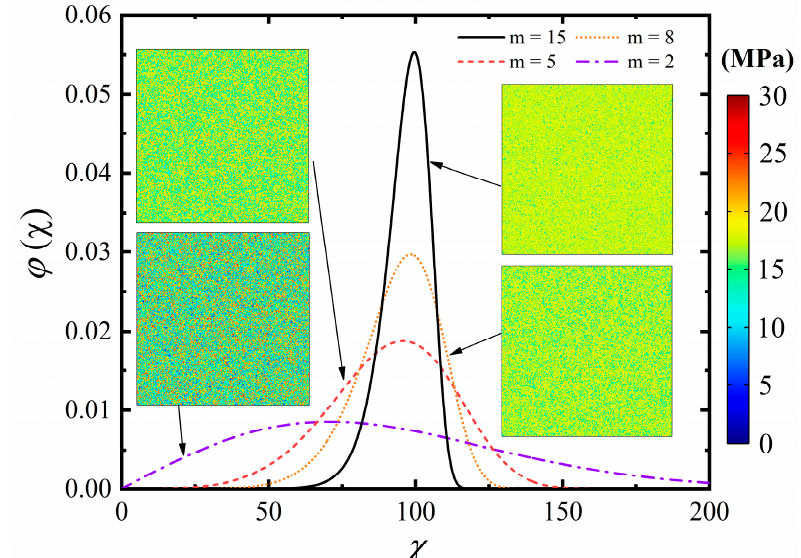
Figure 11. The number of elements with a particular value as a function of that value for different homogeneity indices (m = 2, 5, 8, and 15) at a given scale parameter of β = 100. Snapshots of the numerical specimens are also provided to show the distribution of tensile strength within specimens characterized by different homogeneity indices (m = 2, 5, 8 and 15).